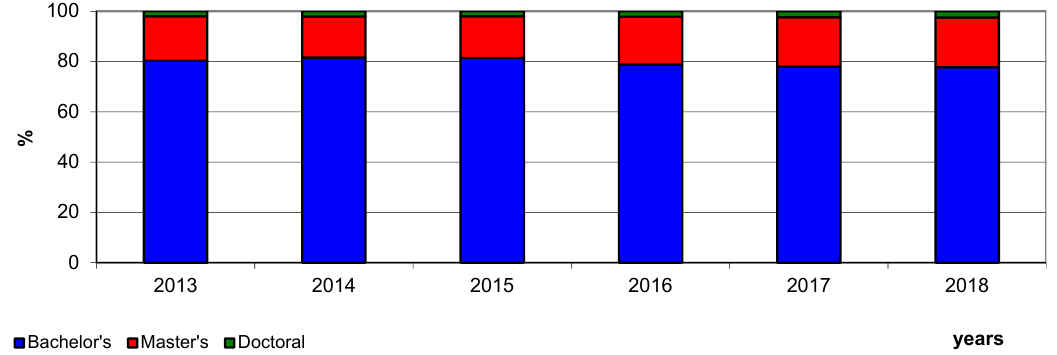
Figure 3. Structure of education in the fields of electricity and energy in Poland in 2013–2018.